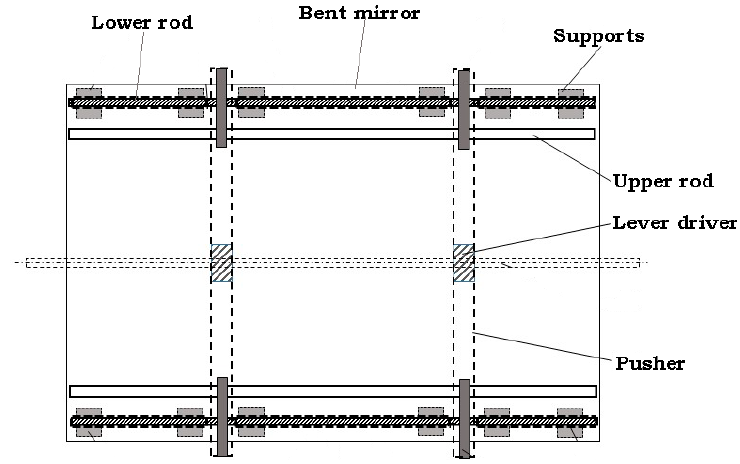
Figure 8. Upper view of the bent mirror.